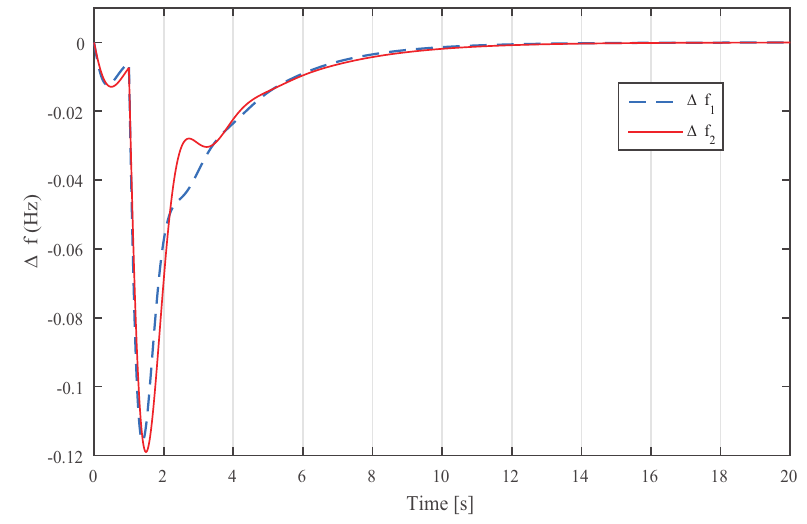
Figure 6. Responding curves of V2G system subjected to SOC.